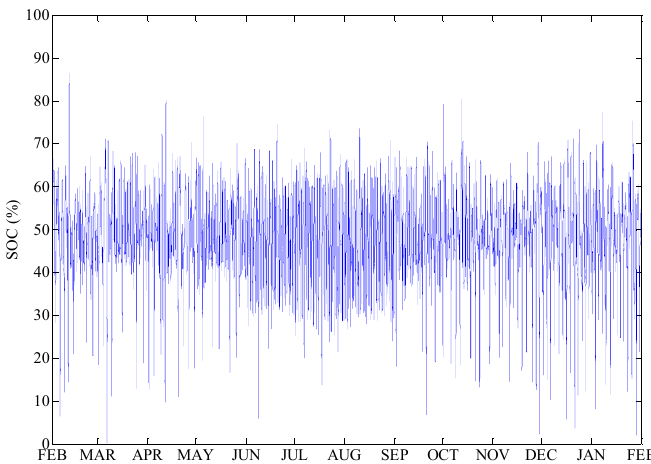
Figure 8. Evolution of the useful SOC during a year.